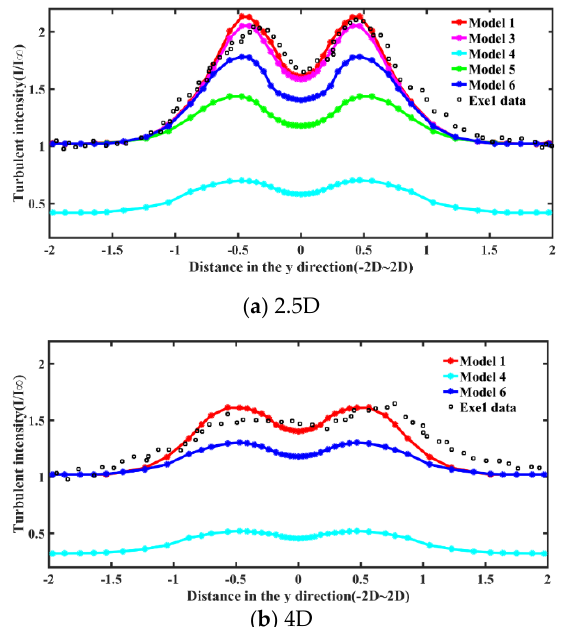
Figure 13. Turbulence intensity at the di ff erent cross-sections of the axial direction.